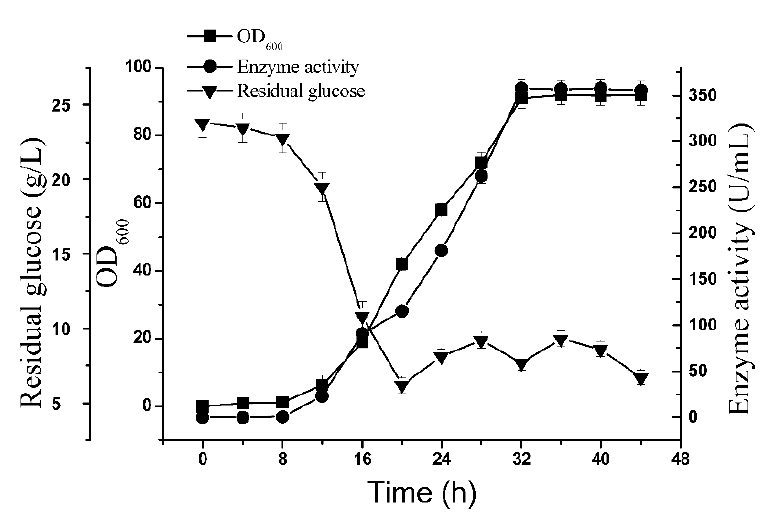
Figure 6. Fed-batch fermentation of the recombinant strain BSM4. The standard errors are calculated from three independent biological experiments.